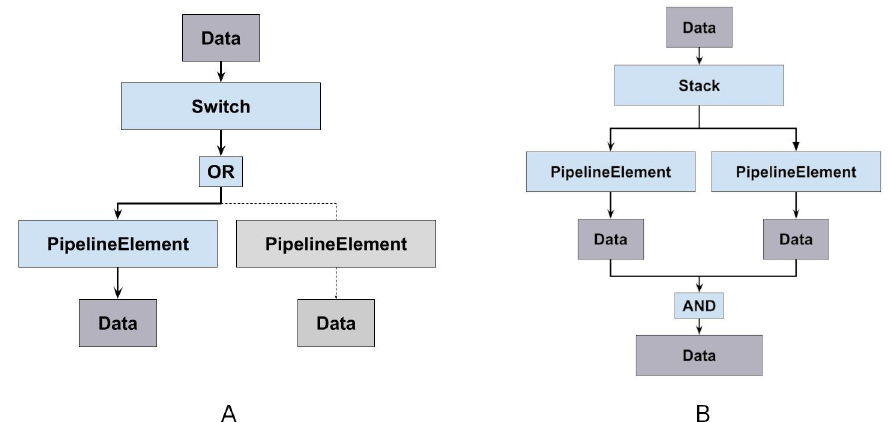
Fig 2. Parallel pipeline elements. A : The Switch class represents an OR-Operation and can be placed anywhere in the sequence to interchange and compare different algorithms at the same pipeline position. B : The Stack represents an AND-Operation and contains several algorithms to share a particular pipeline position. It streams the data to each element and horizontally concatenates the respective outputs (see Listing 3). Next to generating new feature matrices through several processing steps at runtime or building classifier ensembles, it can, in addition, be used in combination with the branch element.